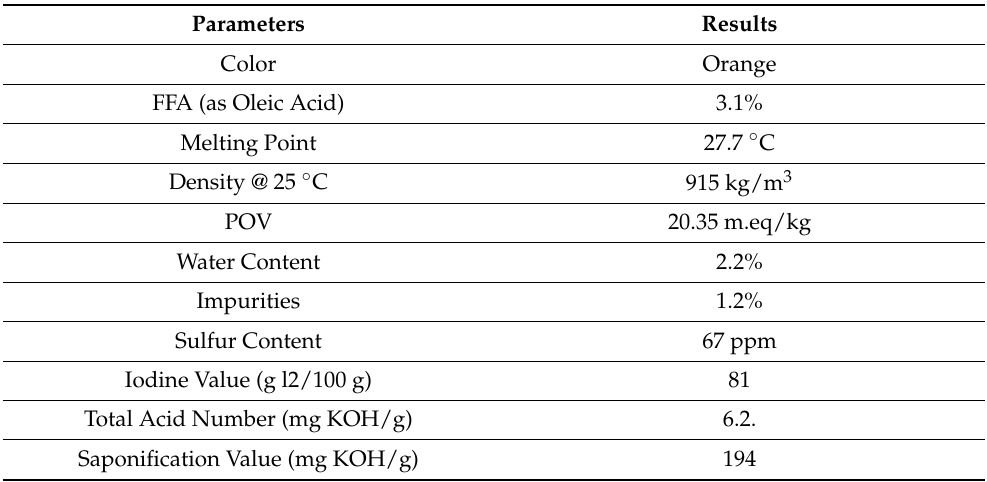
Table 1. Physicochemical properties of waste cooking oil. Parameters